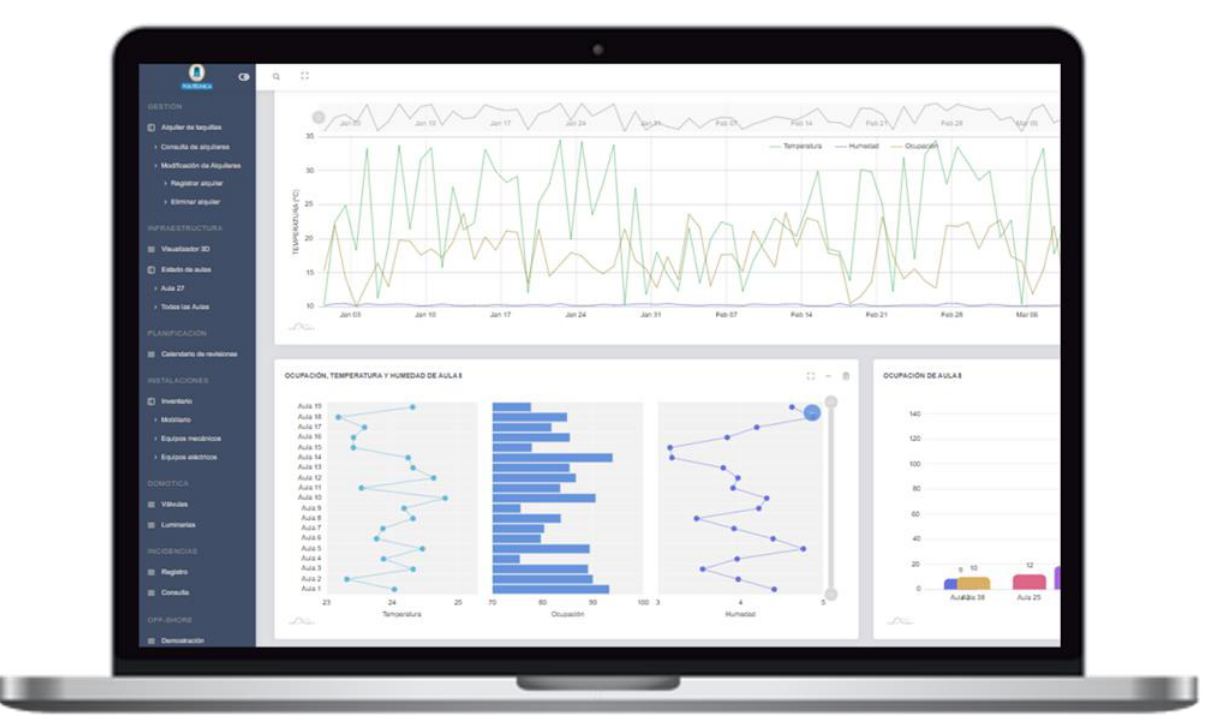
Figure 11. Intelligent platform. Management staff.